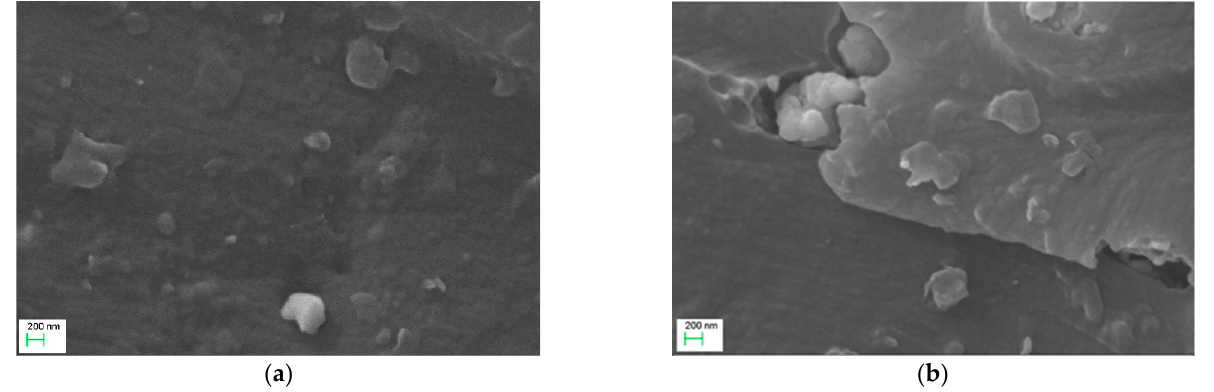
Figure 1. SEM images for the: ( a ) 5 phr SrFe 12 O 19 /10 phr BaTiO 3 /epoxy and ( b ) 50 phr SrFe 12 O 19 /10 phr BaTiO 3 /epoxy,